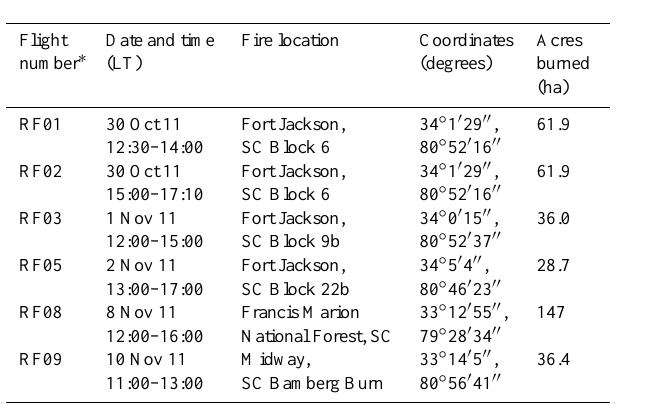
Table 1. Information for each research flight with the PILS-TOC and fraction collector system including flight number, date and sam- pling time (local time, LT) as well as the location and size of the fire being sampled.